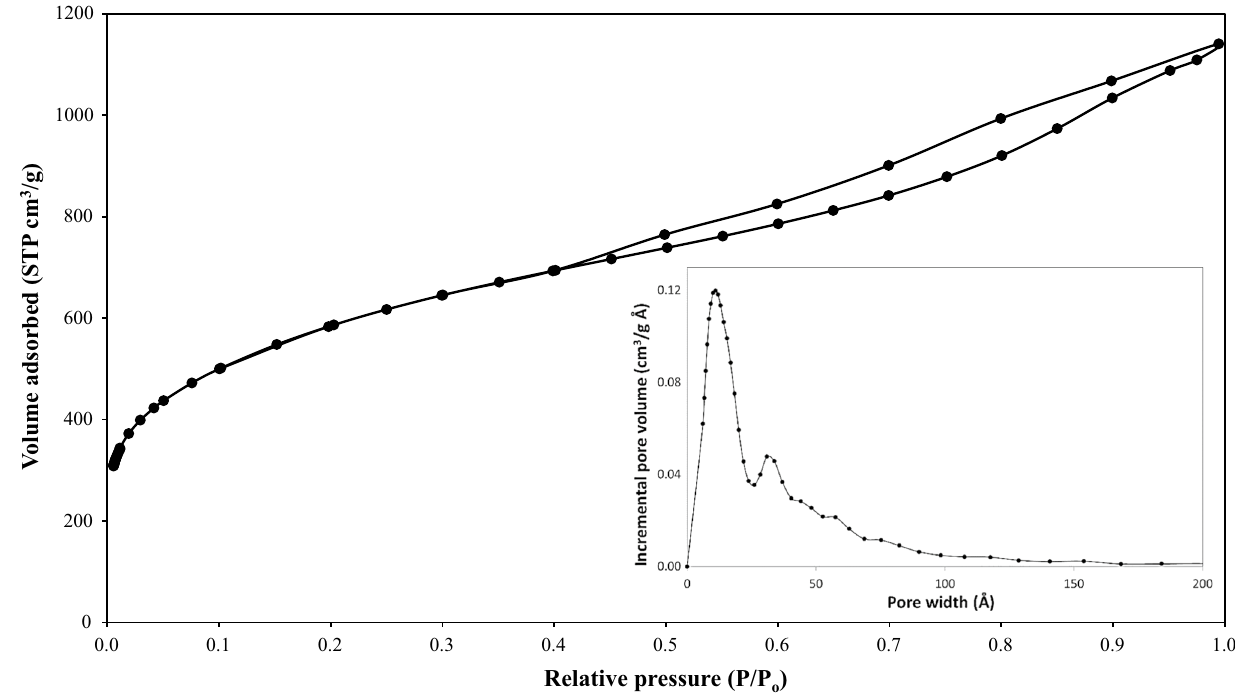
Fig. 3 N 2 adsorption–desorption isotherm and pore-size distribution of KOH activated carbon (AC2-50)